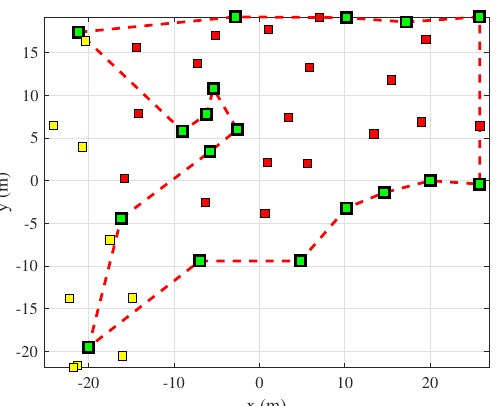
Figure 8. A revisiting path constructed using the proposed covariance TSP algorithm. The yellow squares are non-selected landmarks; the red squares are landmarks selected for revisiting; the green squares are the revisiting positions dictated by the VLU grid map; the red dotted line is the optimal revisiting path defined by the covariance TSP